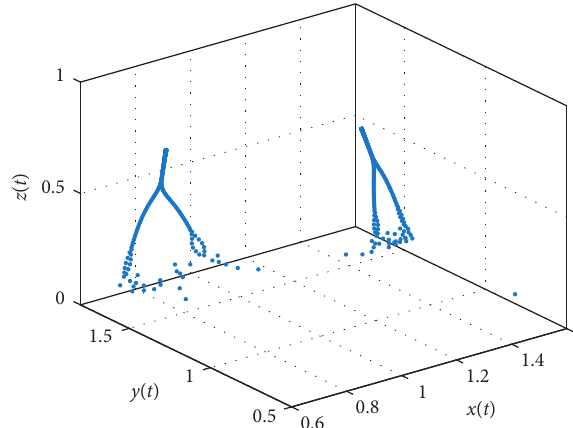
� 0.7 and α � 0.21. 1 2